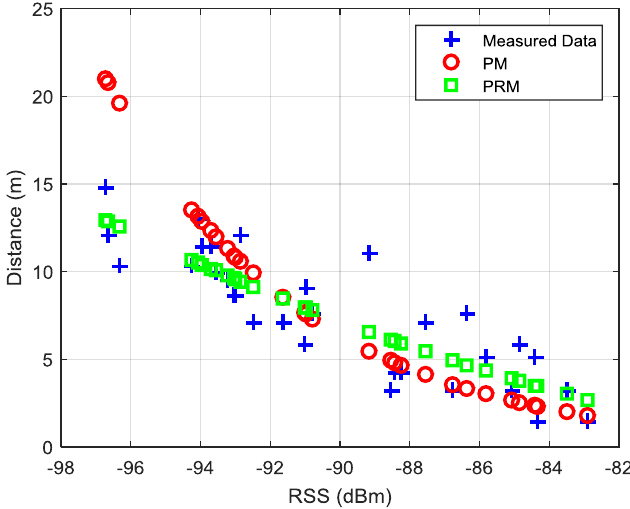
Figure 6. Measured data and distance estimation results.